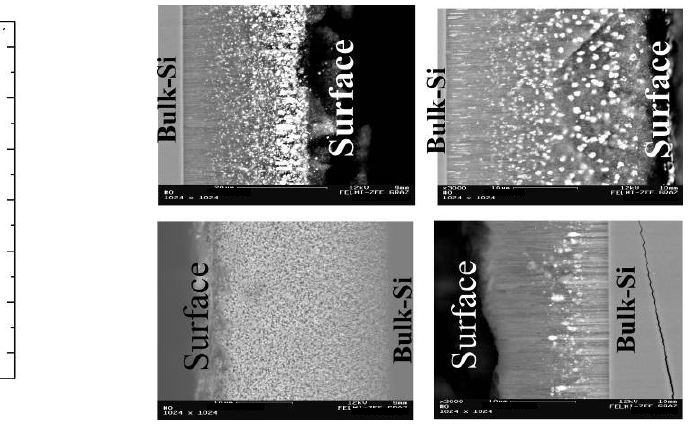
Figure 21. Left: Relation between current density and depth of the metal deposition in consideration of the pulse duration which has also to be adjusted [84]. Right: Micrographs gained from back scattered electrons showing the Ni-distribution within the porous silicon layers (accumulated near the surface, distribution of dispersed nanostructures over the entire porous layer, homogeneously distributed, accumulated near the